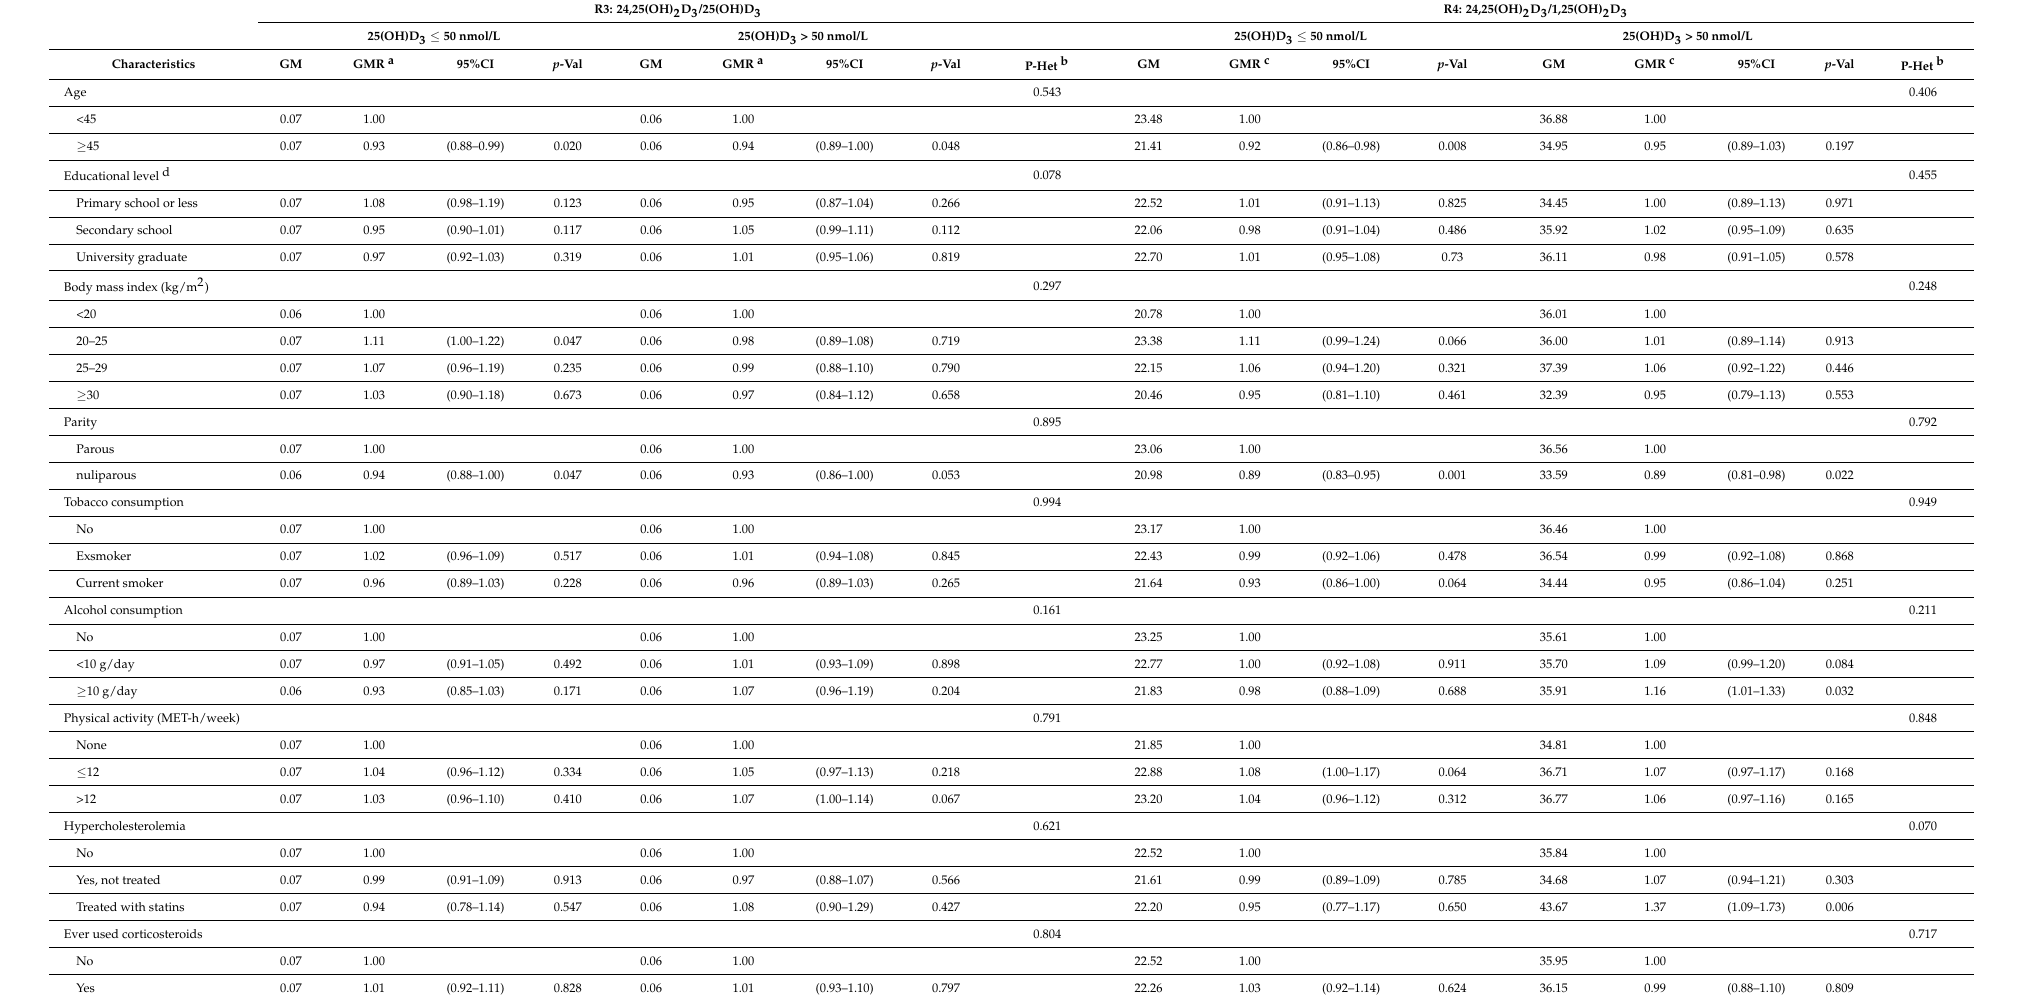
Table 5. Association between R3 and R4 metabolite ratios and characteristics of women according to vitamin D